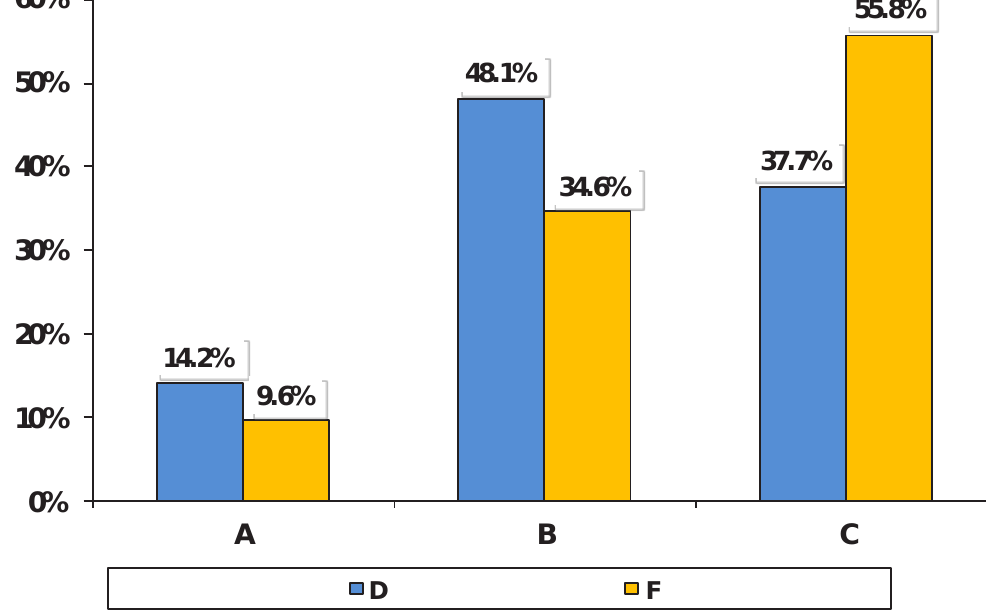
Fig. 1 . Percentage distribution of daytime and extramural form of study students by levels of physical activity: A – high level; B – average level; C – low level; D – daytime form of study; F – extramural study form of